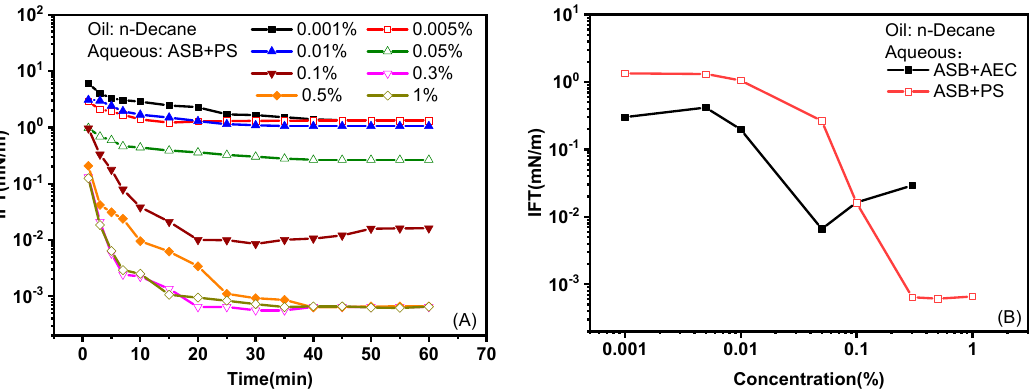
Figure 1. Effect of concentration on dynamic IFTs of ASB@PS ( A ) and equilibrium IFTs of ASB@PS and ASB@AEC ( B ) solutions against n-decane.